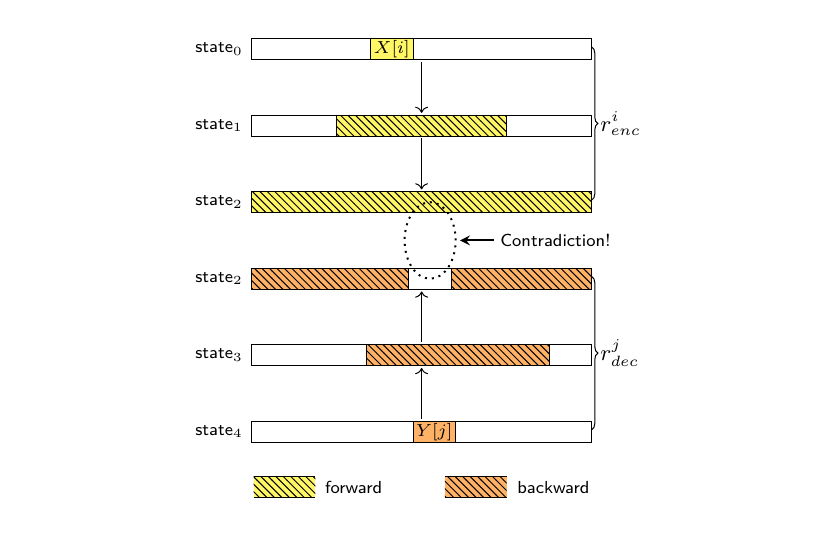
Figure 5: Building impossible differential distinguisher